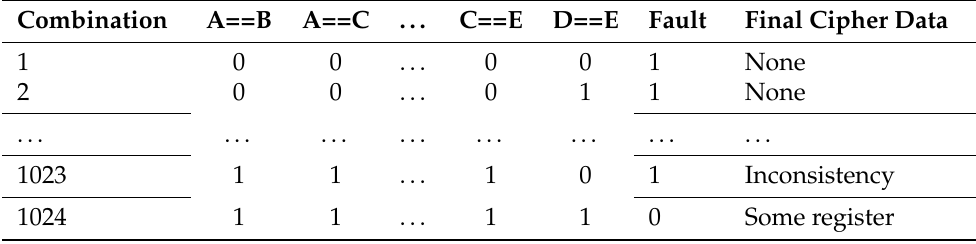
Table 2. Truth table for